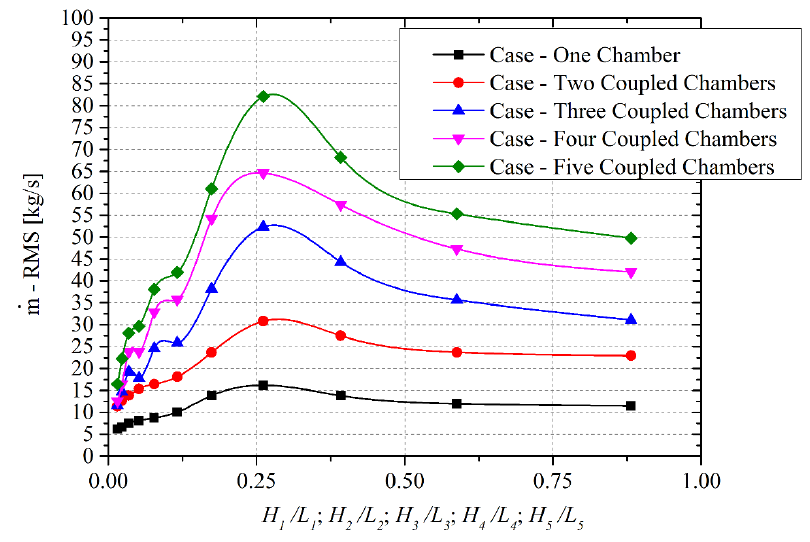
Figure 13. Accumulated mass flow rate in each coupled device.